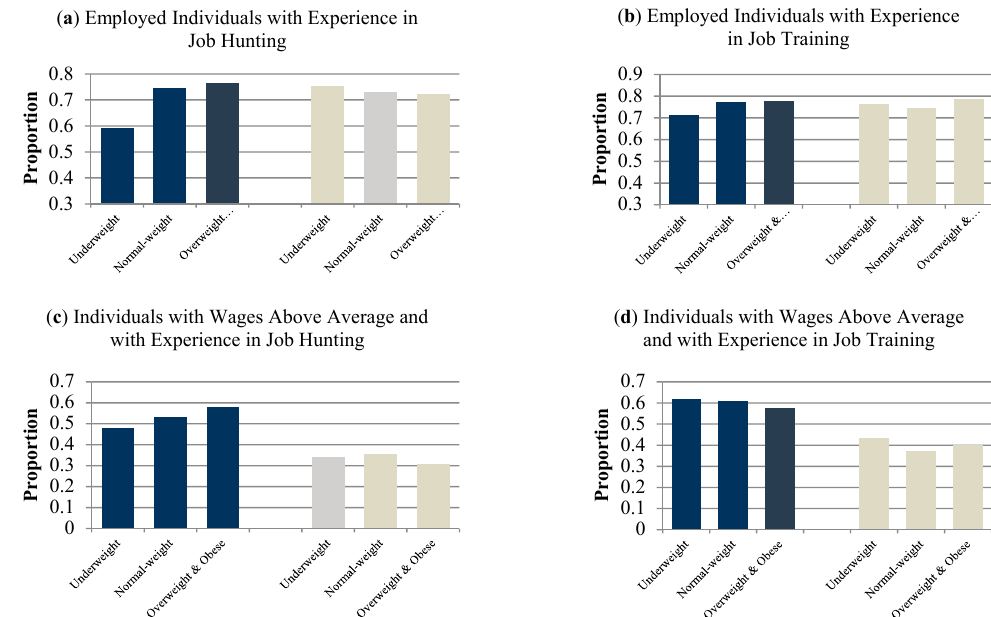
Figure 3. Proportions of employed individuals and of individuals with wages above average with experience in job hunting and of job training by gender and BMI classification groups. Note: The dark blue bars represent men and the beige bars represent women. ( a , b ) depicts results regarding the dependent variable of current employment status and ( c , d ) analyzes the dependent variable of wage above average.